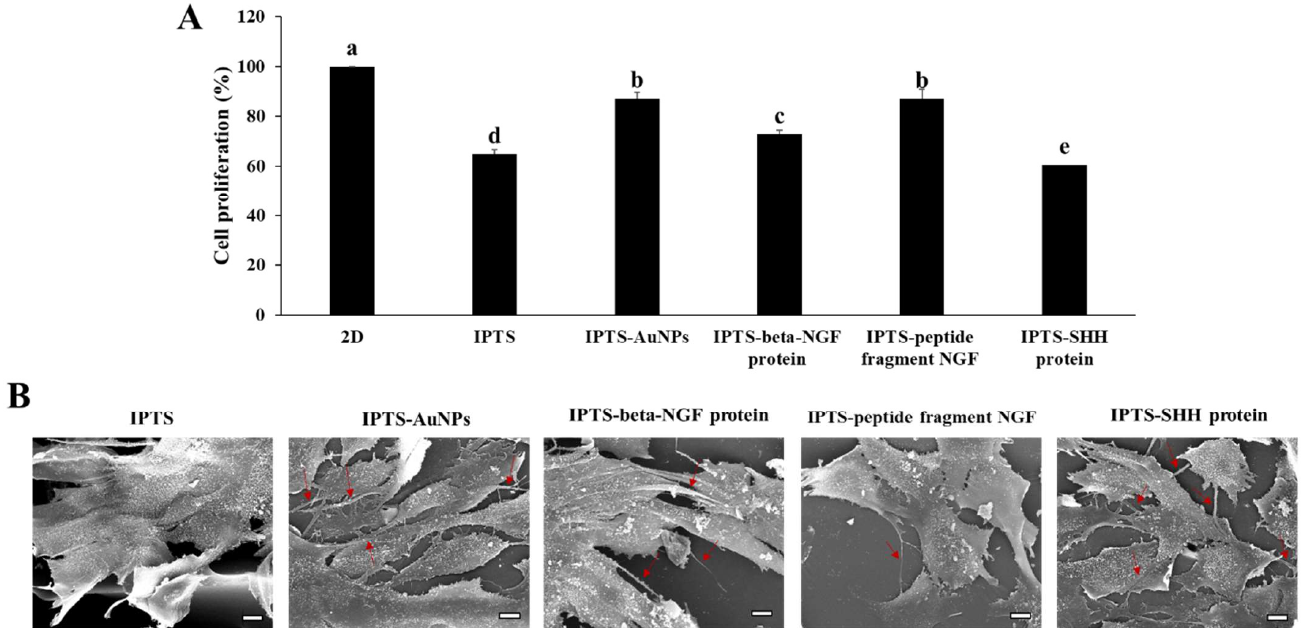
Figure 4. Proliferation of F3.Olig2 NSCs cultured on industrial PLA three-dimensional scaffold (IPTS) chips coated with gold nanoparticles (Au-NPs), nerve growth factor (NGF) protein, NGF peptide fragments, or sonic hedgehog (SHH) protein, compared with that of control cells cultured on a non-coated IPTS or a two-dimensional cell plate. Cells were seeded at a density of 5 × 10 3 cells/mL. ( A ) Viability of non-differentiated F3.Olig2 NSCs after 2 days of culture using the WST-1 proliferation assay kit. Data are presented as the mean ± standard deviation. The bars not sharing a common lowercase letter (a–e) are significantly different according to Duncan’s multiple range test ( p < 0.05). ( B ) Scanning electron microscopy images of F3.Olig2 NSCs cultured on the various IPTS chips (scale bar: 10 µ